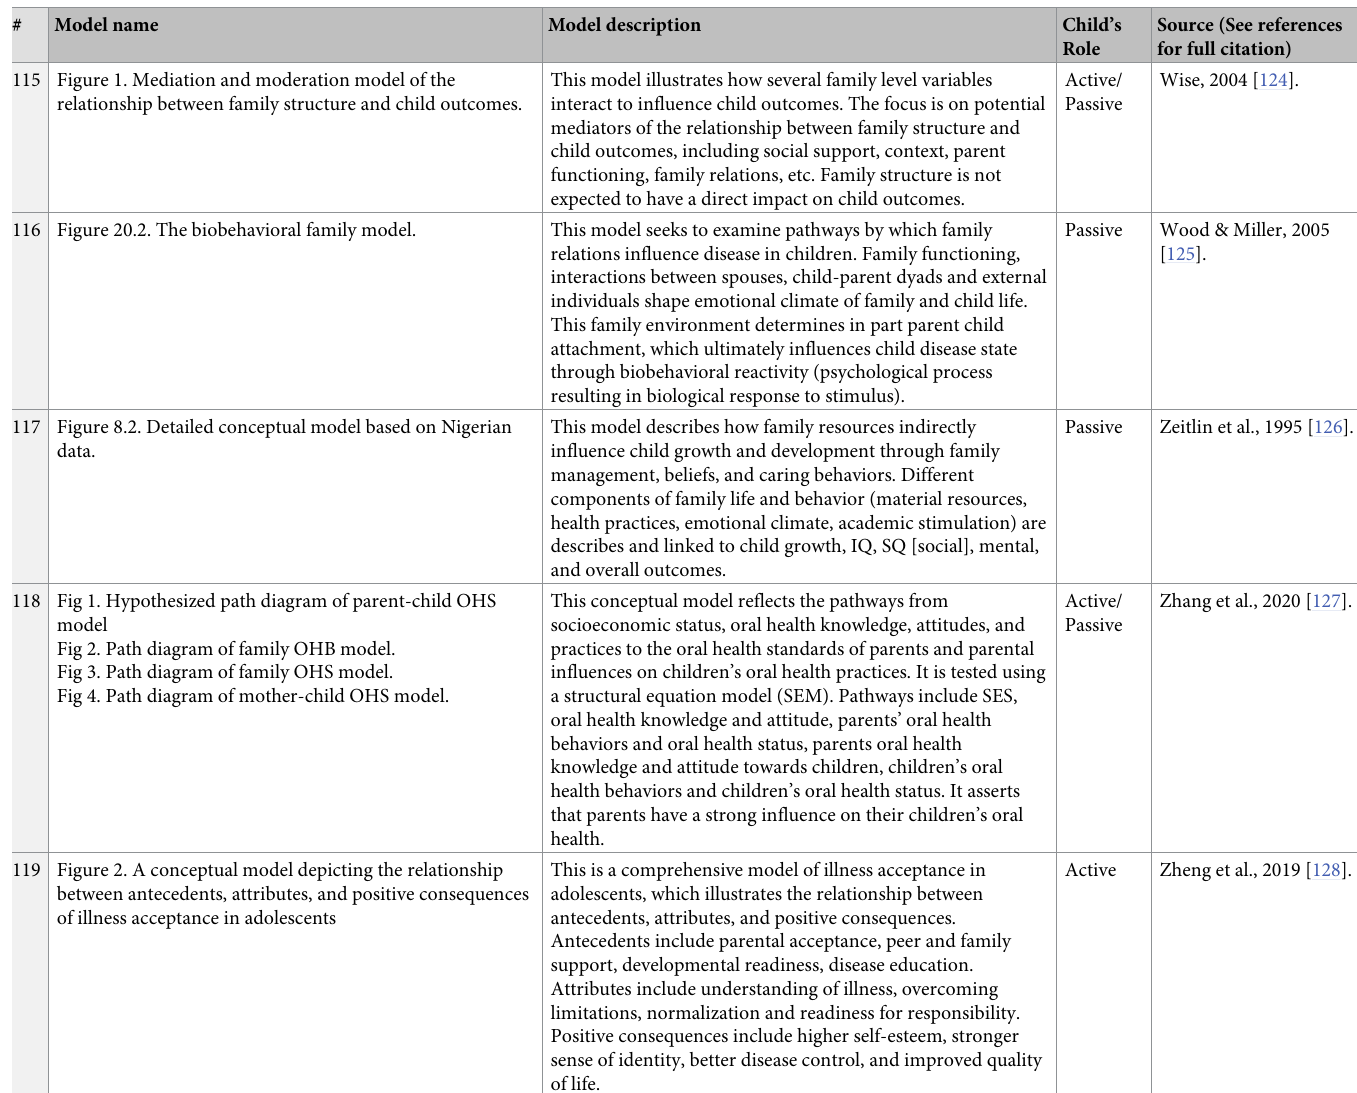
115 Figure 1. Mediation and moderation model of the relationship between family structure and child outcomes.